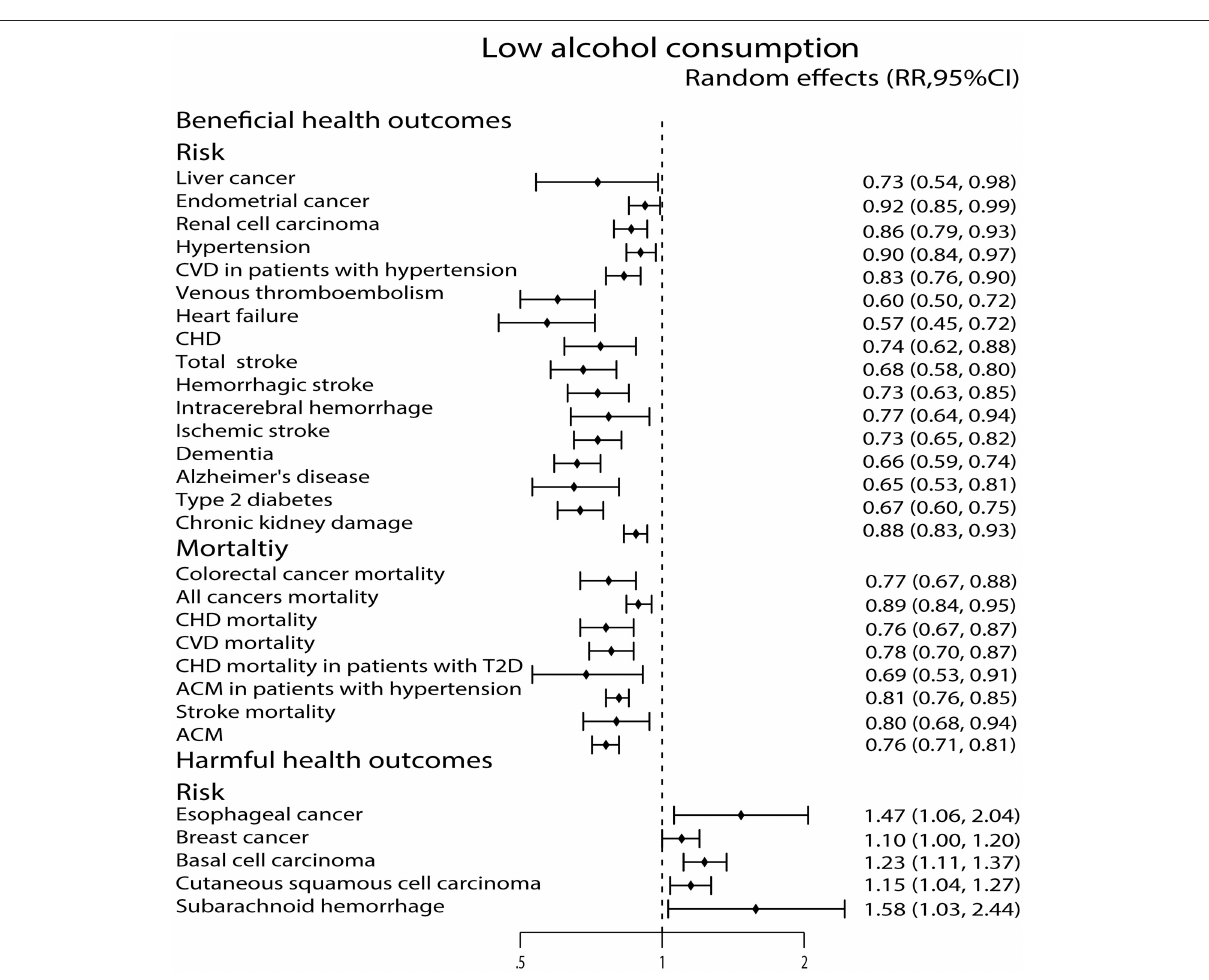
Frontiers in Public Health |